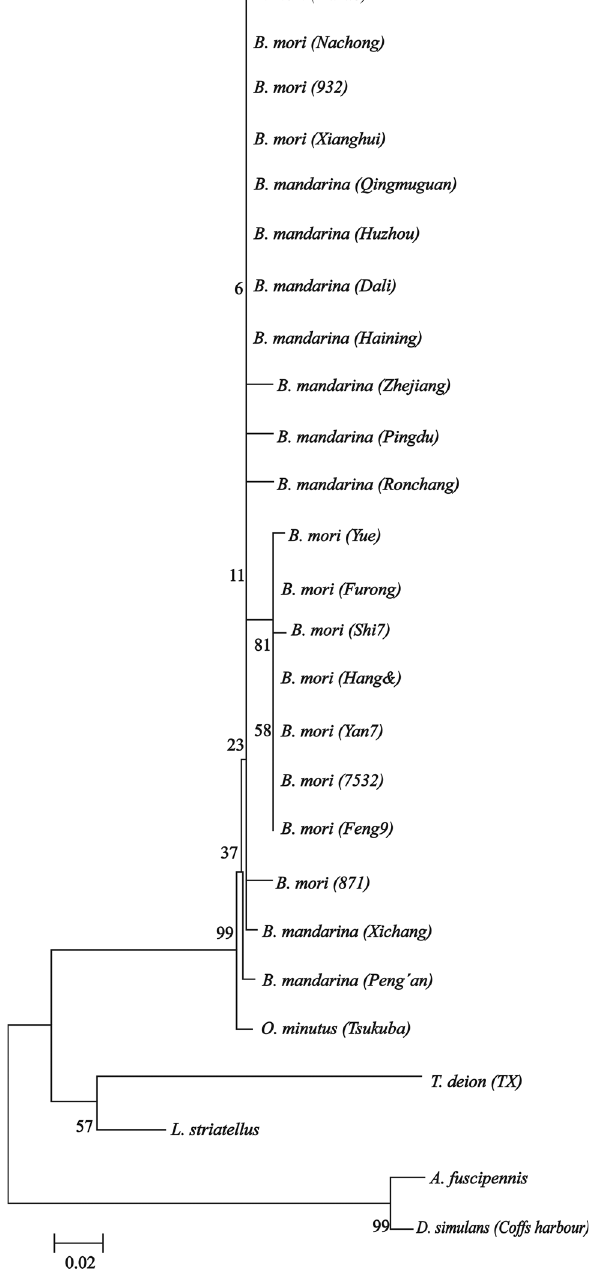
Figure 3 - Phylogenetic tree of Wolbachia in silkworms. All 21 wsp se- quences from samples of silkworms were used to construct the tree.